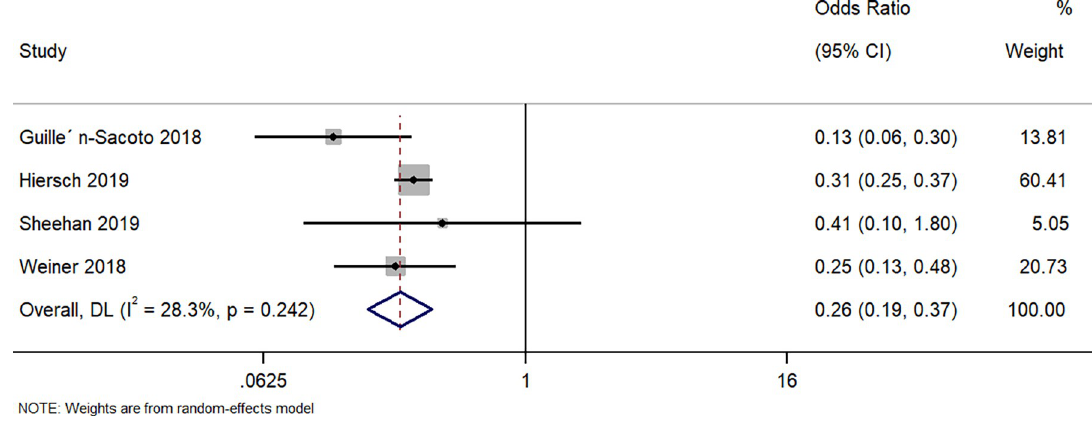
PLOS ONE | https://doi.org/10.1371/journal.pone.0280754 January 25,